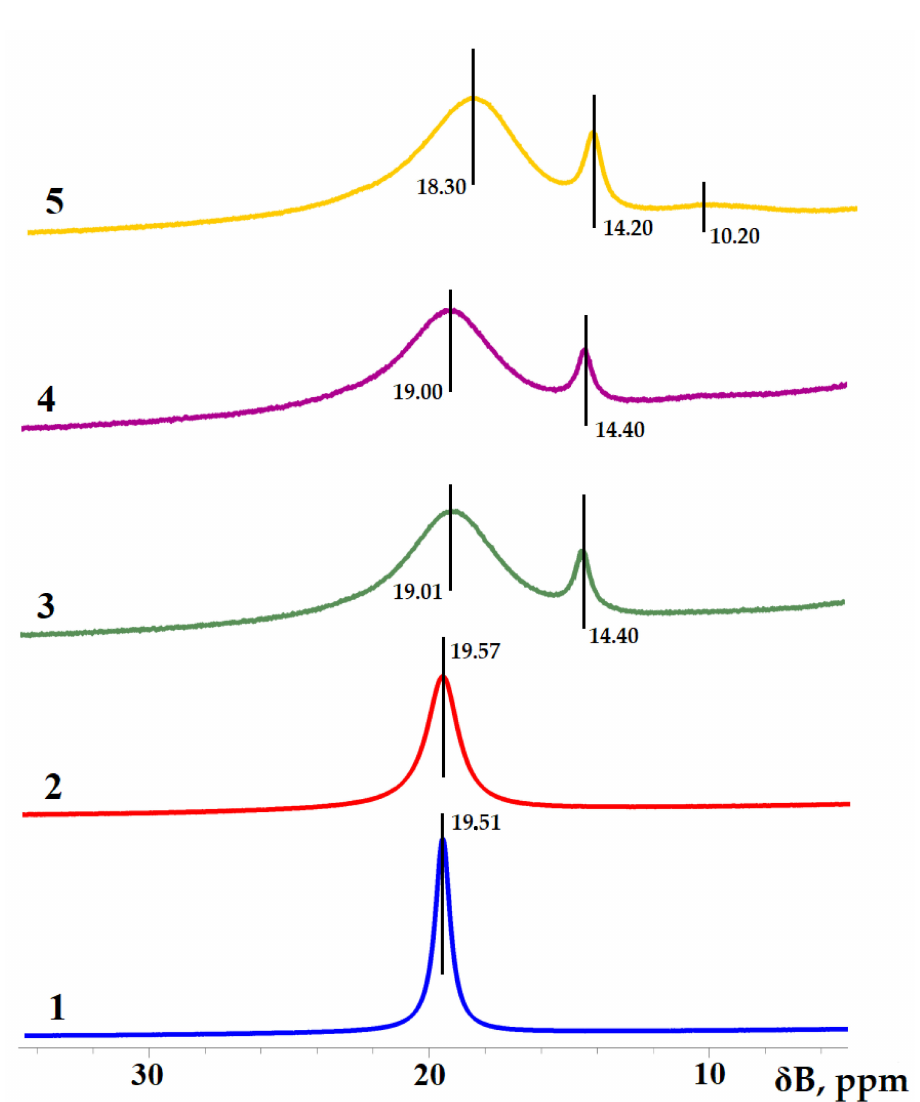
Figure 4. 11 B NMR spectra of compounds obtained at the following molar ratios: 1—[H 3 BO 3 ]:[PEG] = 1:1 (19.51 ppm); 2—[H 3 BO 3 ]:[PEG] = 1:3 (19.57 ppm); 3—[TEA]:[H 3 BO 3 ]:[PEG] = 1:6:12 (AEBA) (19.01 ppm;